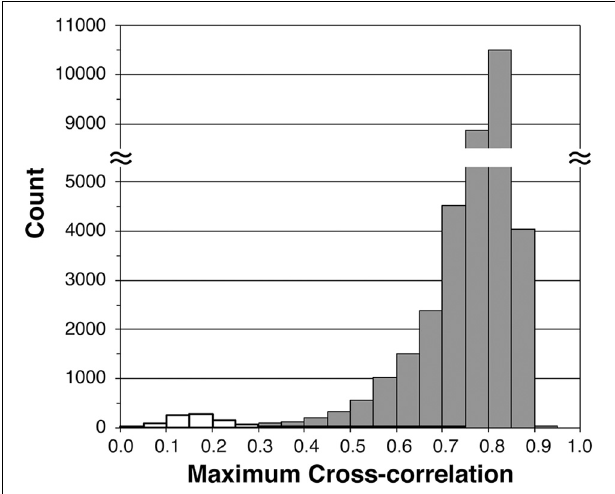
FIGURE 9 | Histogram of the maximum value of CCF. The white bars show the frequency distribution for the waveforms without significant acoustic ranging signal.